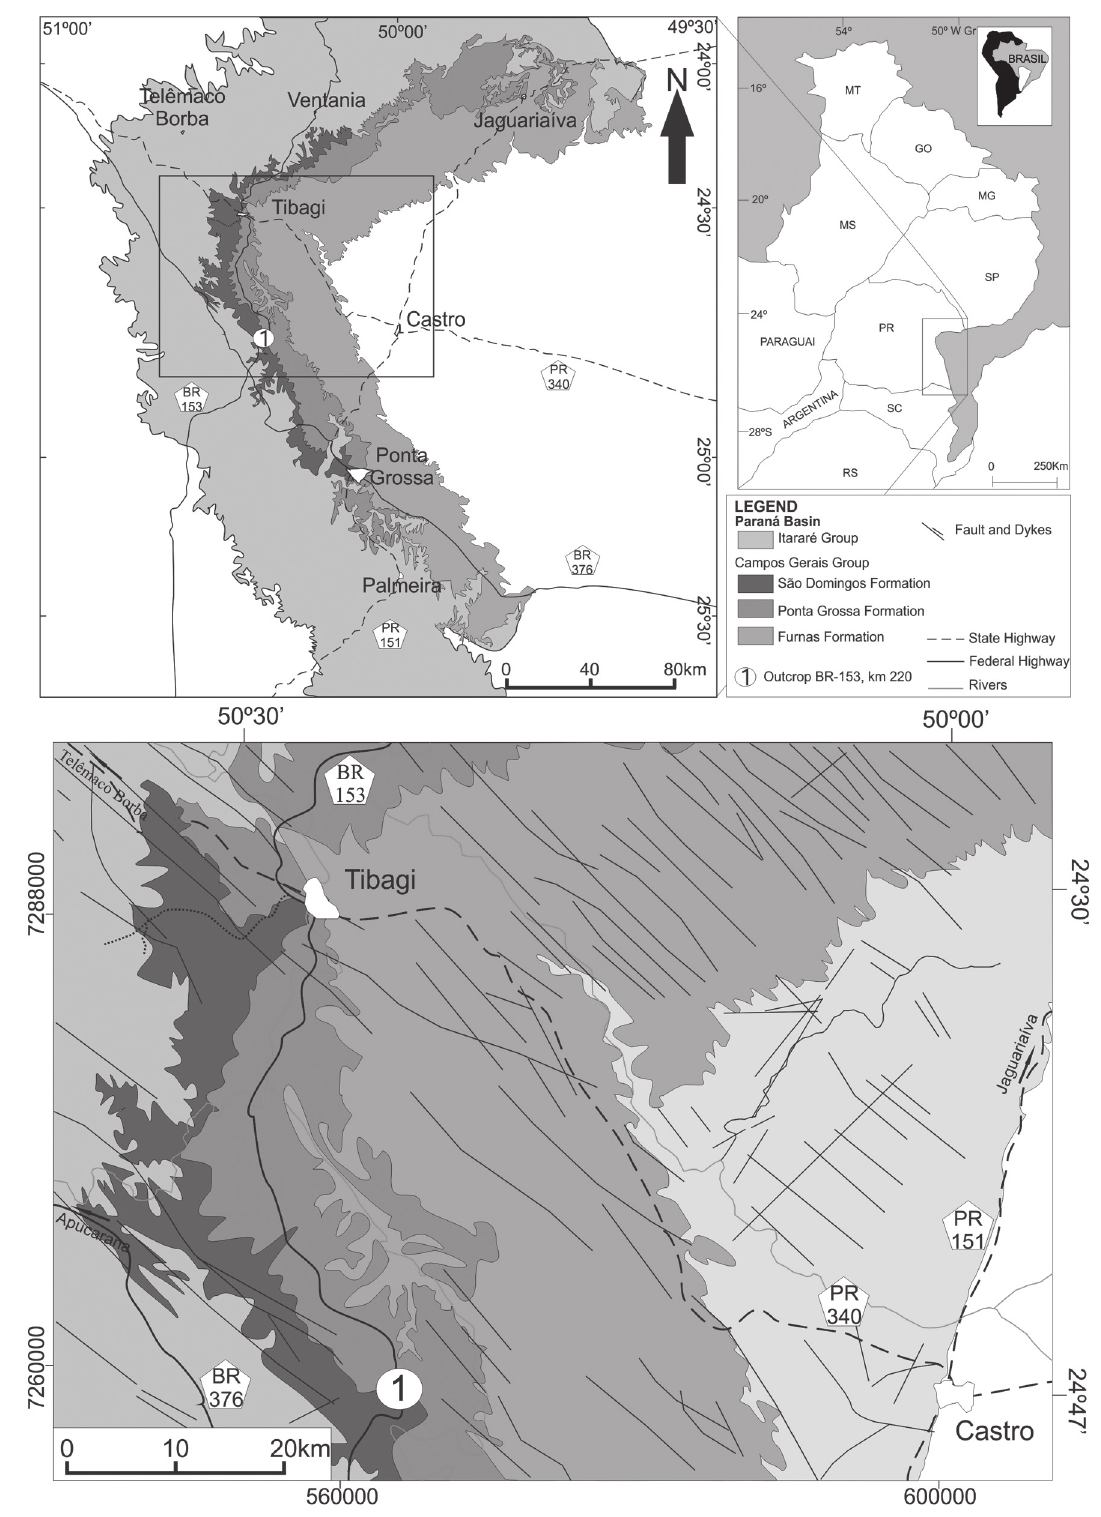
Figure 1 - Location map of the fossiliferous outcrop (1) in the State of Paraná,